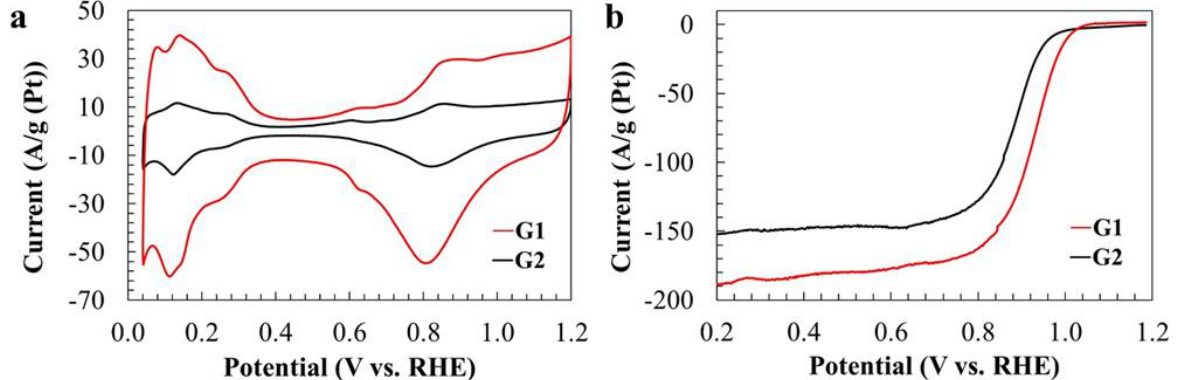
Figure 6. ( a ) CVs of Pt/C catalysts, two cycles, Ar − atmosphere; ( b ) LSV curves for ORR of Pt/C, 1600 rpm, O 2 − atmosphere. The potential scan rate is 20 mVs − 1 , the electrolyte is 0.1 M HClO 4 , and Т = 60 °С.